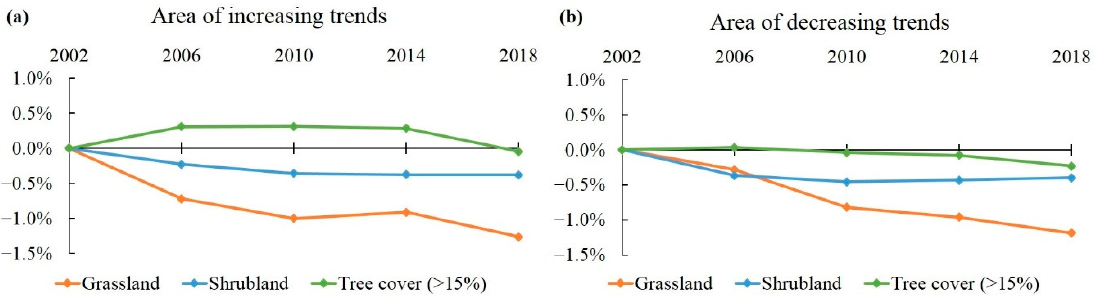
Figure 8. Changes in area of natural land cover classes (grassland, shrubland and forest) since 2002 to 2018, ( a ) in increasing trends clusters, and ( b ) in decreasing trend clusters.